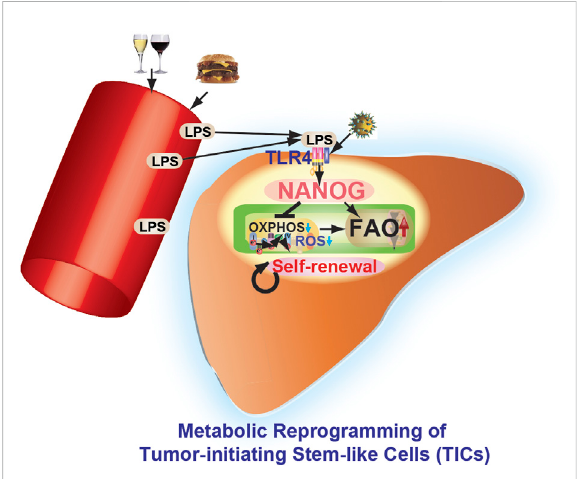
FIGURE 4 Pluripotency transcription factor NANOG contributes to cancer progression by mitochondrial reprogramming leading to the genesis of TICs. Environmental factors (alcohol and high-fat diet) and virus infection (i.e., hepatitis C virus) promote metabolic reprogramming and other characteristics of TICs. Obesity and alcoholism increase gut permeability leading to endotoxemia, which in turn activates Toll-like receptor 4 (TLR4) in the liver with induction of pluripotency transcription factor NANOG and an in fl ammatory response. This leads to subsequent development of obesity/alcohol-related liver cancer. NANOG ChIP-seq identi fi ed novel gene targets needed for oxidative phosphorylation (OXPHOS) and fatty acid oxidation (FAO). OXPHOS and fatty acid metabolism are identi fi ed as major pathways contributing to NANOG-mediated oncogenesis. NANOG-ChIP sequencing, gene pro fi ling, proteomics, and metabolomics approaches were all combined to identify the altered pathway(s) in tumors. NANOG repressed OXPHOS and mitochondrial reactive oxygen species (ROS) in TICs. Restoration of OXPHOS and inhibition of FAO restored drug susceptibility of TICs.Identi fi cationofnovelmetabolicpathwaysprovidespotential drug targets for neutralizing the activity of highly malignant